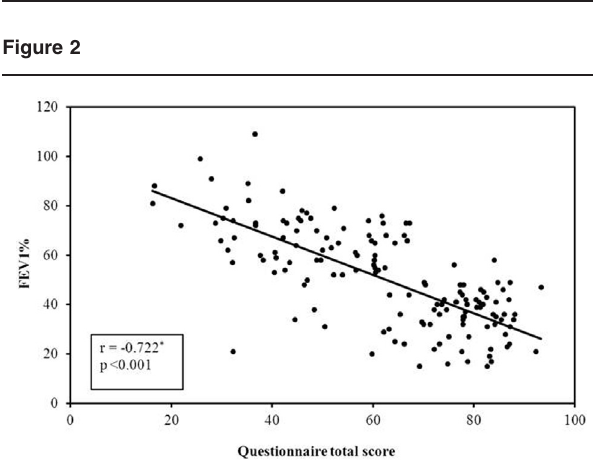
Correlation between FEV 1 % and St George ’ s Respiratory Question- naire.